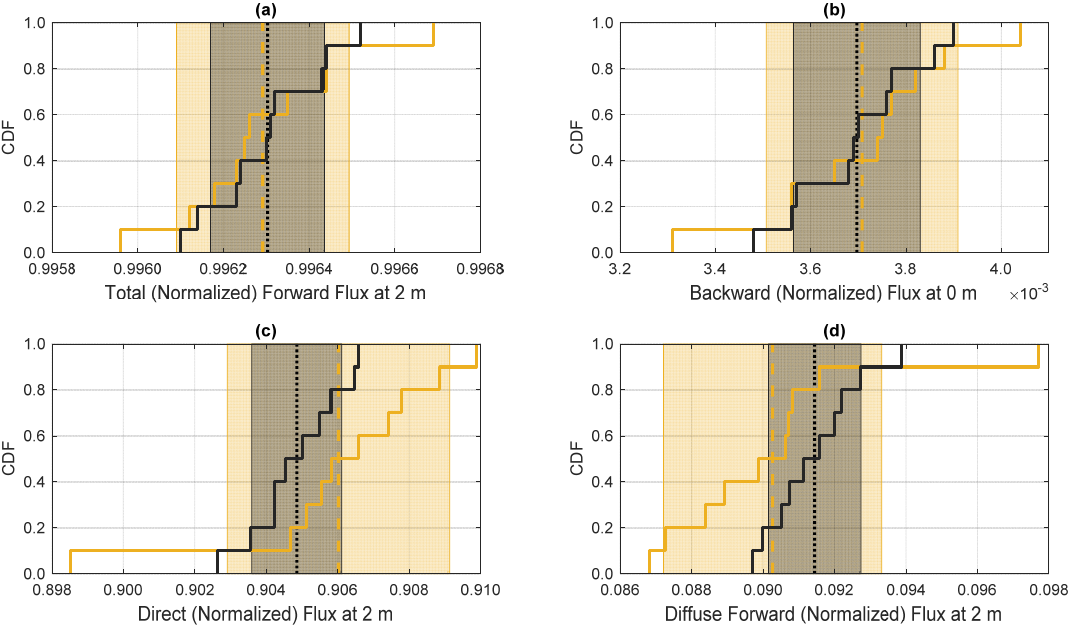
Figure 8. Solid, stepped lines are Cumulative Density Functions (CDFs) calculated from the flux results at the simulated boundaries of the two 10-element sets of scattering simulations with expected optical depths near 0.1, one with LES-positioned particles with spatial correlations arising from turbulent mixing (yellow) and the other with uniformly random droplet locations (black). Both sets of results employed the same LES-exported particle size distribution functions, meaning the only difference between the two sets is the use of LES spatial positions vs. uniformly random positions (same droplet size distribution). Panel ( a ) is total forward flux, panel ( b ) is backward flux, panel ( c ) is direct forward flux, and panel ( d ) is diffuse forward flux. All fluxes are normalized by the incident illumination flux. Mean flux values are shown with dashed and dotted vertical lines, and shaded areas denote plus–minus one standard deviation to show the variation in flux values. All statistics correspond to virtual measurements at 2 m (end surface of the chamber) for all forward fluxes and at 0 m (incoming surface of the chamber) for the backward flux.